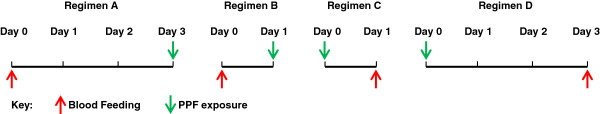
Description of the treatment regimens.